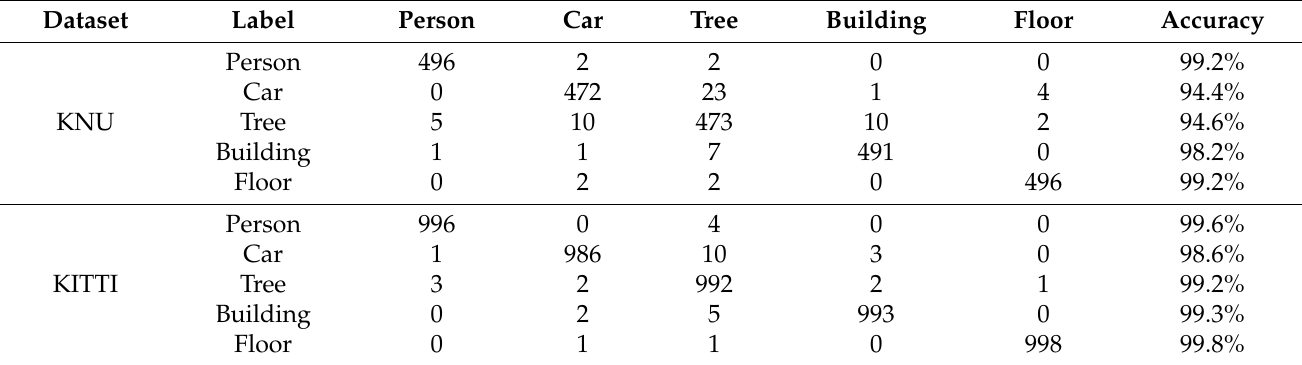
Table 2. Classification performance according to learning using sP 2 images for two datasets.